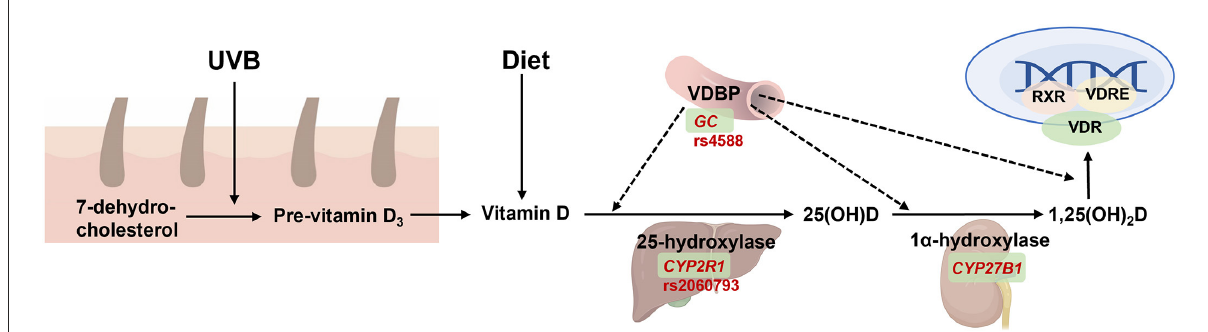
FIGURE5 The function of GC on vitamin D synthesis, transport, and metabolism. 7-dehydrocholestrol is converted to pre-vitamin D3 and then to vitamin D in the skin under ultraviolet radiation b (UVB) exposure. Vitamin D is also absorbed from diet and then transferred by binding with vitamin D binding protein (VDBP, encoded by GC ) into liver to form 25(OH)D by 25-hydroxylase (encoded by CYP2R1 ), and then transferred into the kidney by VDBP which form the active metabolite 1,25(OH)2D by 1 α -hydroxylase (encoded by CYP27B1 ). The latter is then transferred to targeted tissue to combine with binding to vitamin D receptor (VDR), and then activate gene expression together with retinoid-X-receptor (RXR) and vitamin D response element (VDRE). Created with